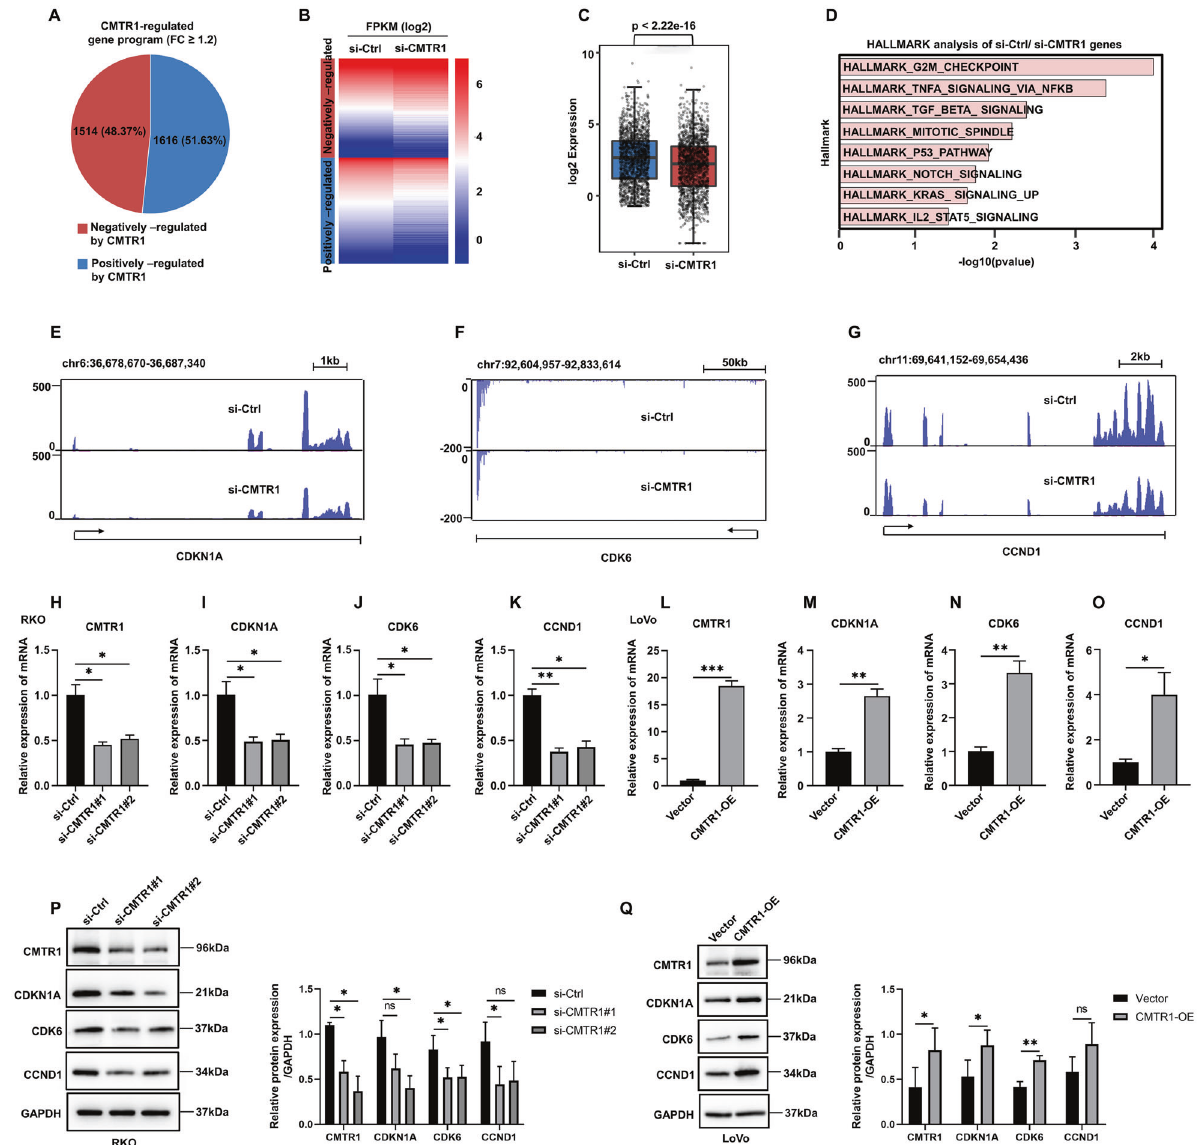
Fig. 2 CMTR1 regulates the expression of a group of genes involved in the cell cycle. A RNA-seq was conducted on RKO cells transfected with control siRNA (si-Ctrl) or CMTR1 siRNA (si-CMTR1). A pie chart was used to show genes positively and negatively regulated by CMTR1. B , C The expression levels of genes positively and negatively regulated by CMTR1 are displayed in a heatmap and a box plot. D Hallmark gene set analysis revealed the gene term with the greatest enrichment of genes positively regulated by CMTR1. E – G Graphical presentation of the effects of CMTR1 on representative cell cycle-related genes, such as CDKN1A, CDK6, and CCND1, as determined by RNA-seq. H – Q Expression of CDKN1A, CDK6, and CCND1, measured by RT ‒ qPCR and western blotting in CMTR1 knockdown and CMTR1-overexpressing cells. * P < 0.05, ** P < 0.01, and *** P <